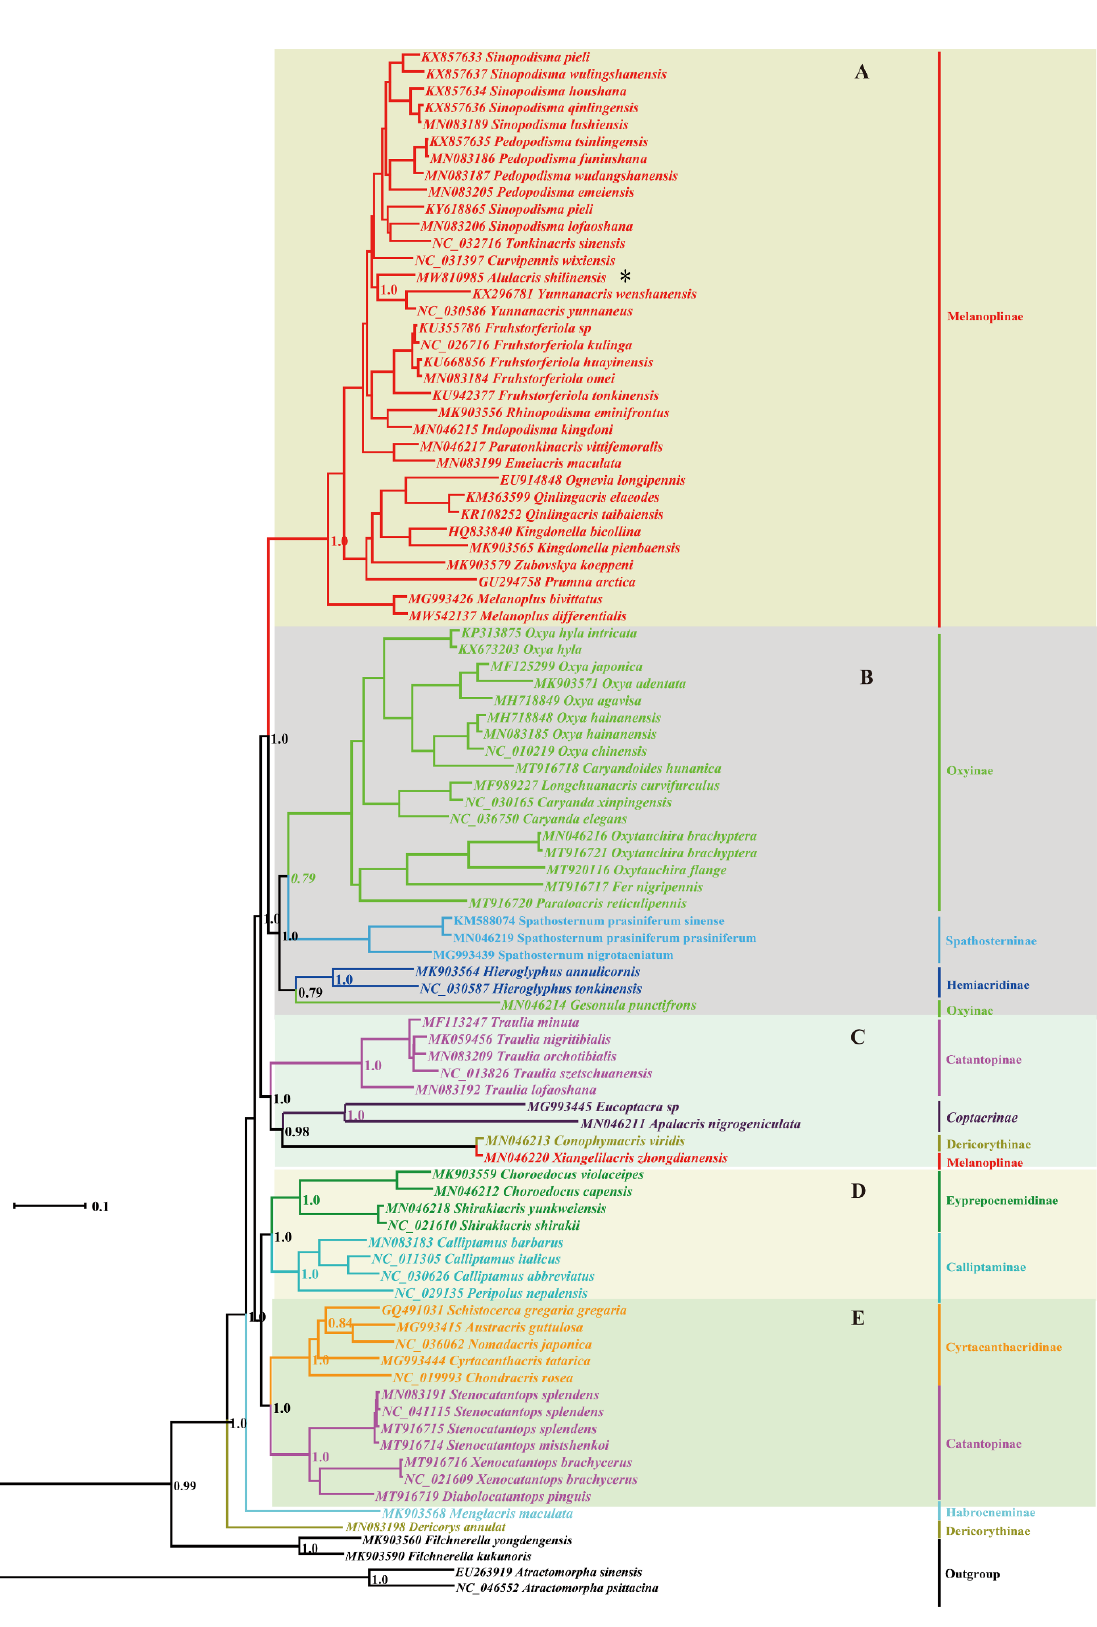
Figure 4. Phylogenetic tree reconstructed from sequences of the 13 mitogenome PCGs(protein-coding genes) and two rRNAs using Bayesian inference. The asterisk indicates the species Alulacris shilinensis . ( A ). Melanoplinae (excluding the genus Xiangelilacris ). ( B ). Oxyinae+Spathosterninae+Hemiacridinae. ( C ). Coptacrinae+ Traulia + Conophymacris + Xiangelilacris . ( D ). Eyprepocnemidinae+Calliptaminae. ( E ). Cyrtacanthacridinae+Catantopinae.